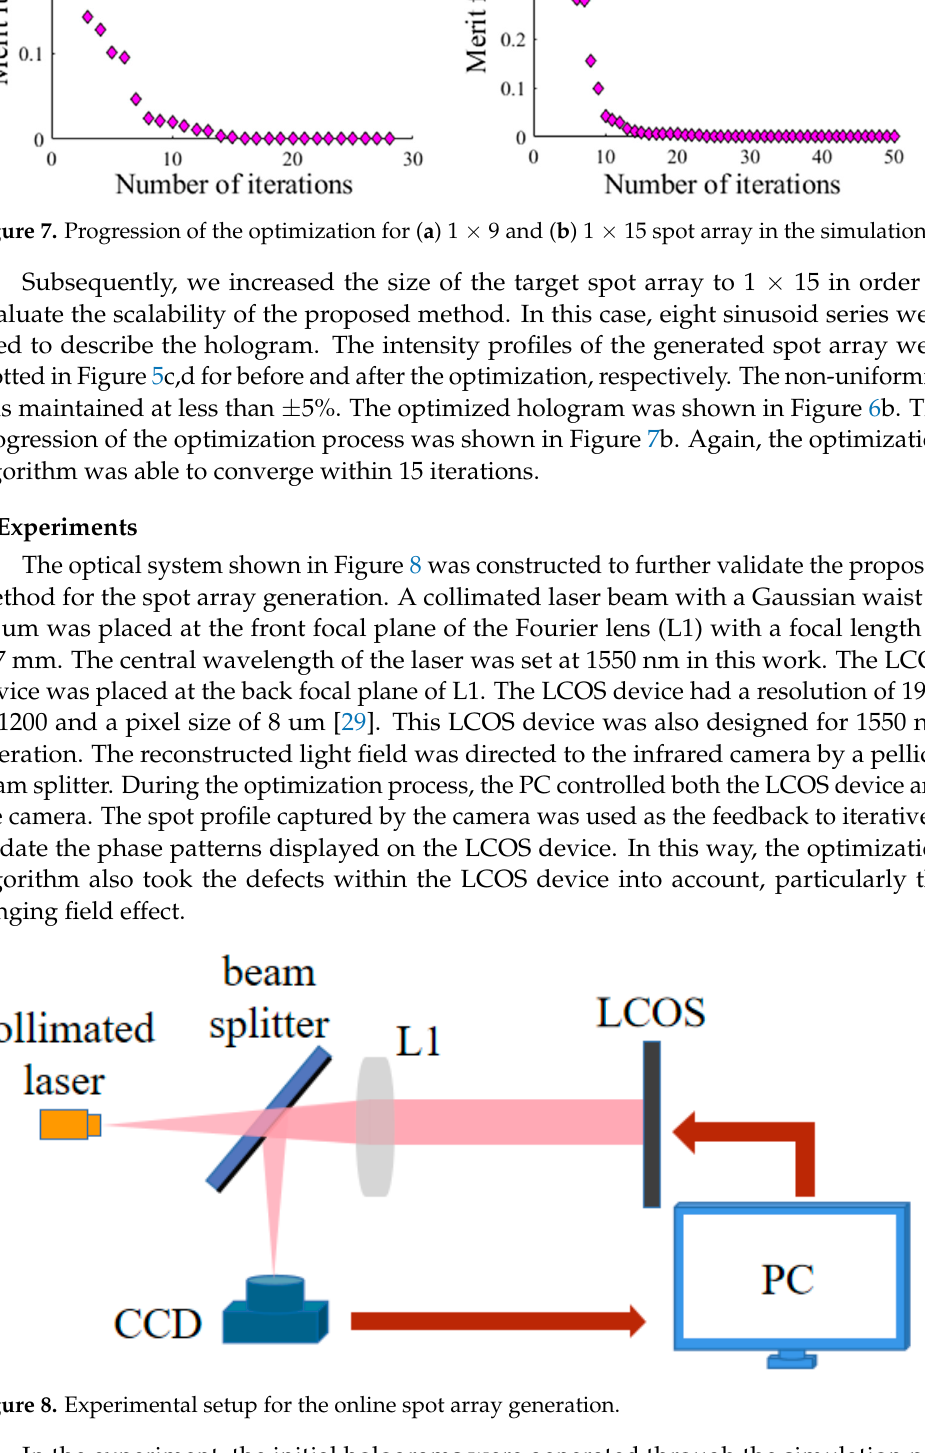
Figure 9. The original and result generated beam spot array for 1 × 9 ( a , b ) and 1 × 15 ( c , d ) in the experiment.